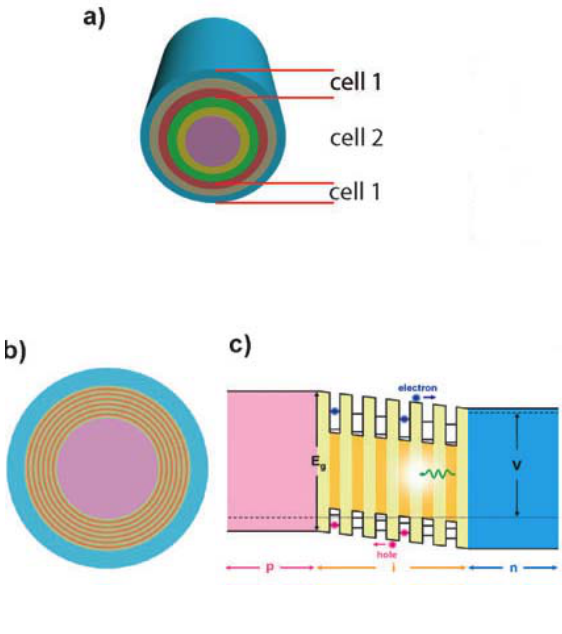
Figure 16. New NW structures for improving energy conversion efficiency. (a) Schematics of axial and coaxial NW tandem SCs. (b) Schematic of an MQW NW SC. Pink and blue regions denote p-core and n-shell, respectively; yellow and orange regions are barriers and quantum wells in the i-shell, respectively. (c) Band structure and carrier transport schematics of an MQW NW SC (reproduced from [68] by permission of The Royal Society of